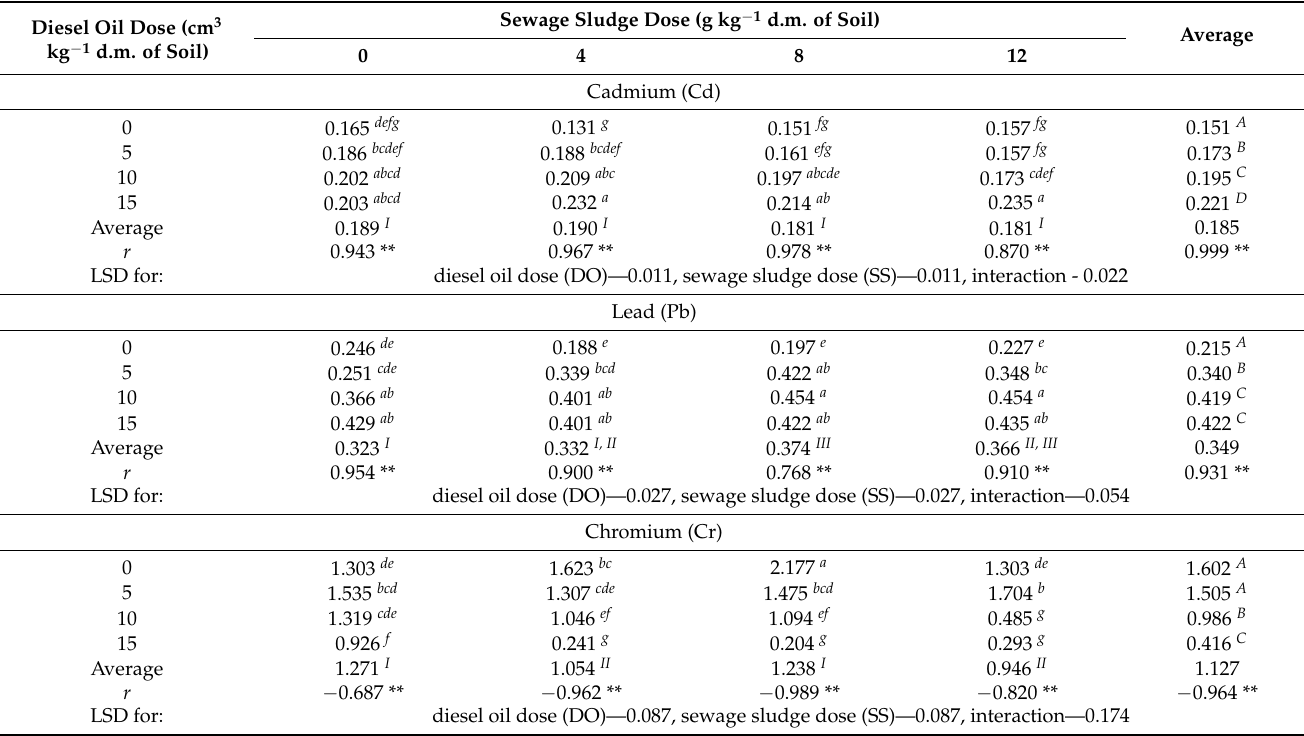
Significant at: ** p ≤ 0.01, * p ≤ 0.05; r—correlation coefficient; values denoted by the different letters and Roman numerals are significantly different at p ≤ 0.01: A – D for diesel oil dose, I – III for sewage sludge dose and a – g for interaction between diesel oil dose and sewage sludge dose (Anova, Tukey’s HSD